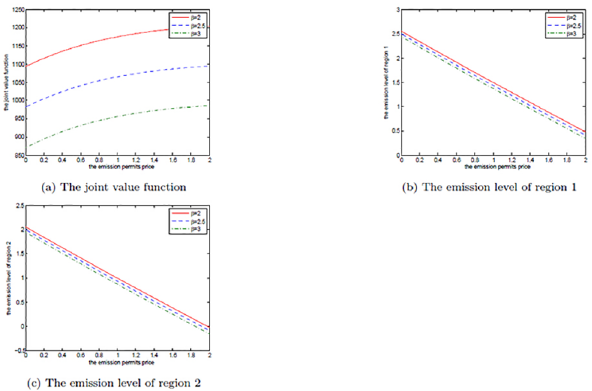
Fig 6. The effects of β on the cooperative